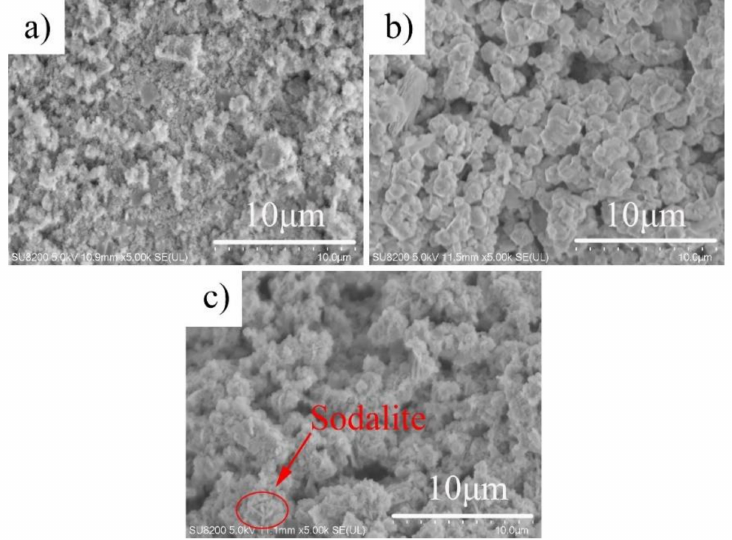
Figure 2. SEM micrographs of the samples A1-T90-H24 ( a ); A2-T90-H24 ( b ) and A3-T90-H24 ( c